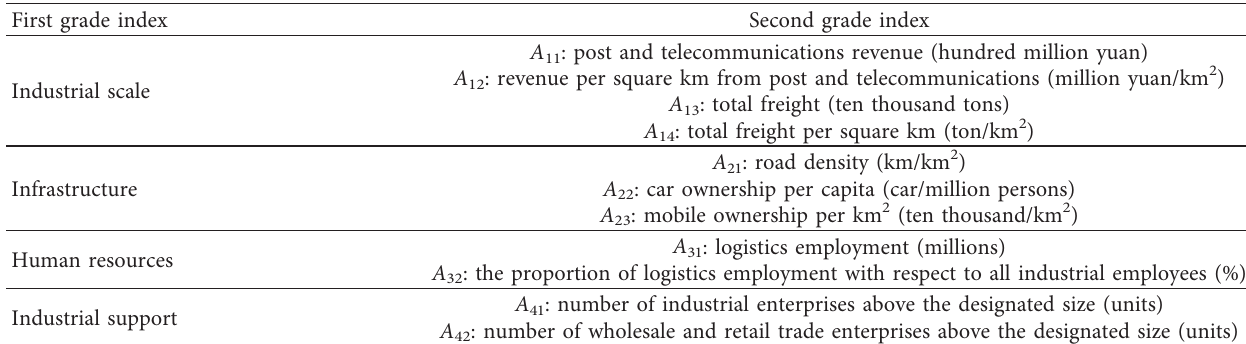
Table 1: Evaluation indices of logistics industry